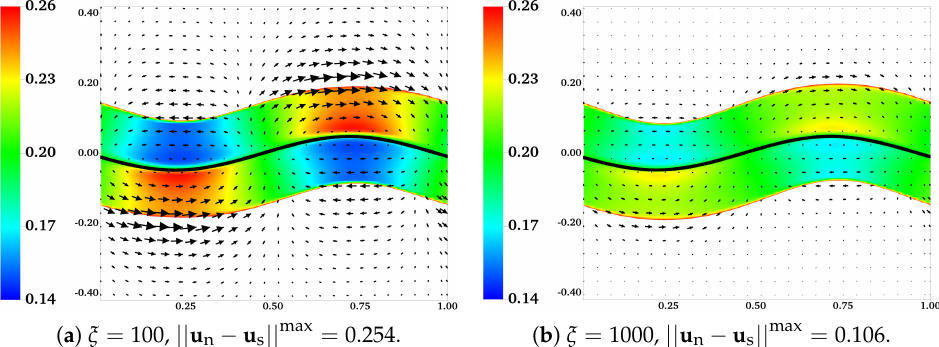
Figure 12. Effect of frictional coefficient: H = 0.16, β = 0.25, θ i n n = 0.2, and θ o ut n = 0.8. Distributions of θ n and velocity difference u n − u s at t = 1.0. All vectors have the same